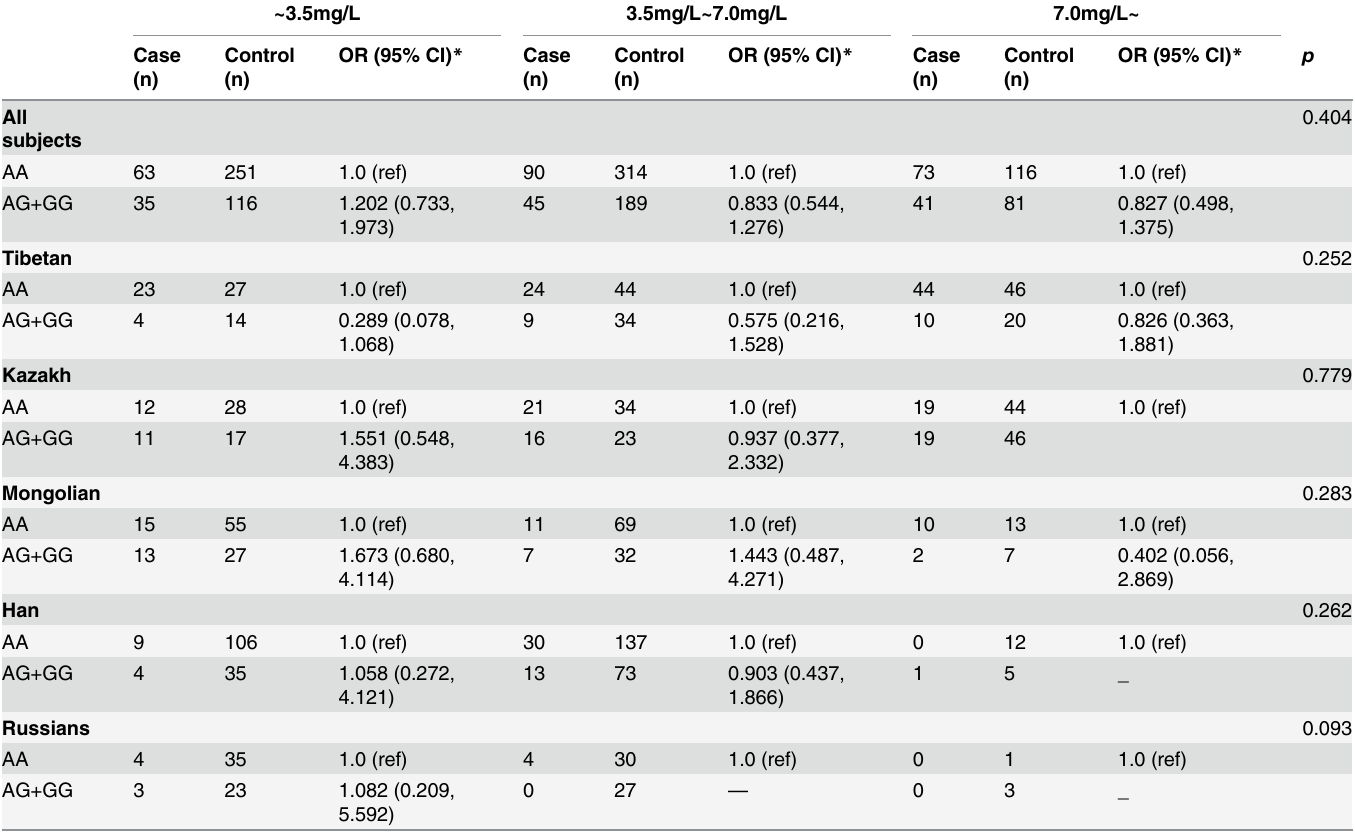
Table 7. Risk of skeletal fluorosis associated with GSTP1 Rs1695 in subjects, stratified by IF